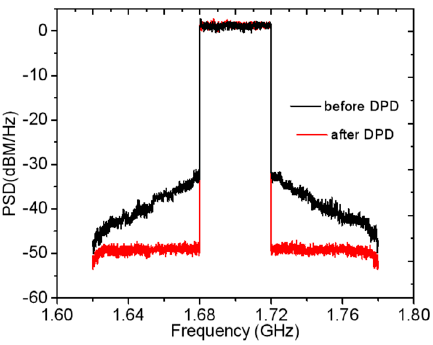
Figure 21. Measured ACLR at 1.7 GHz.